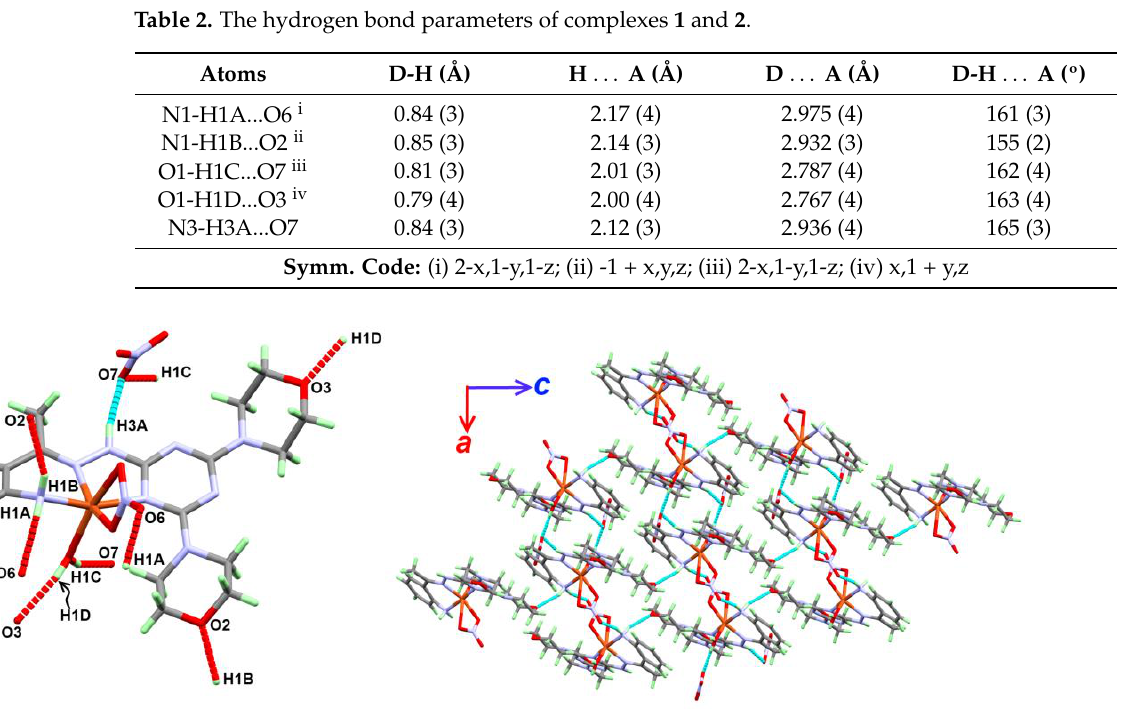
Table 2. The hydrogen bond parameters of complexes 1 and 2 .